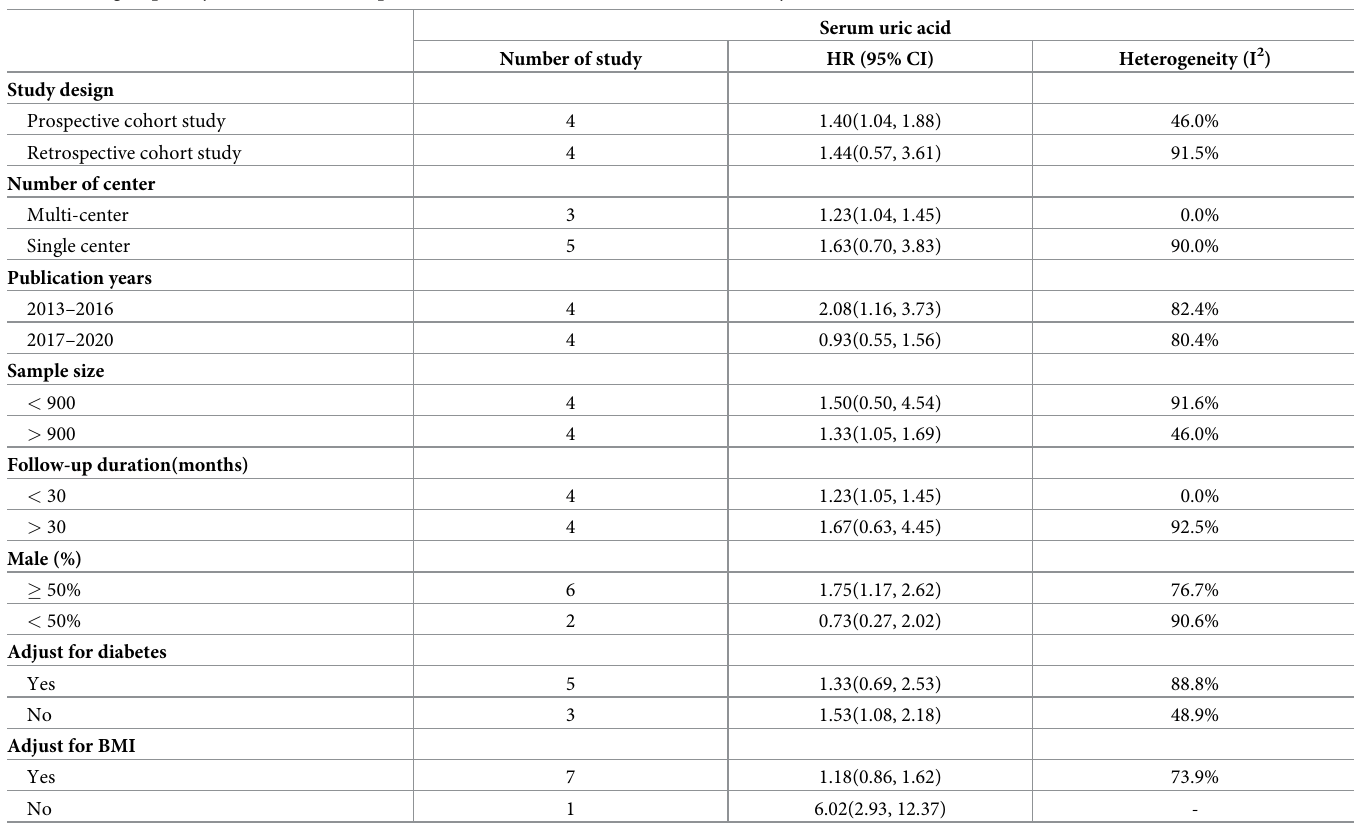
Table 2. Subgroup analysis of the relationship between serum uric acid and all-cause mortality.